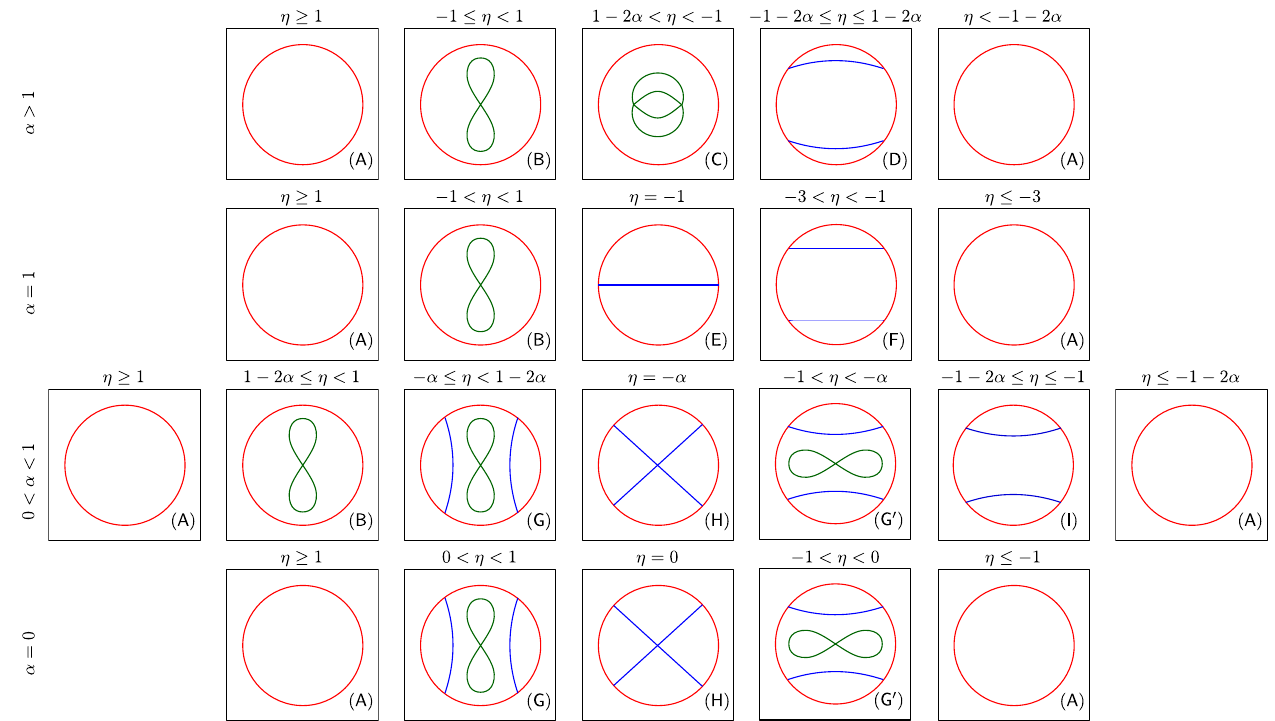
FIG. 3. Possible phase-space topologies for the Hamiltonian (4) as a function of α (vertical direction) and η (horizontal direction), ffiffiffiffiffi ffiffiffiffiffi p p 2 J 2 J using Cartesian coordinates ð cos ϕ ; sin ϕ Þ . Note that η is decreasing from left to right, as we describe a process where η starts at η ≫ 1 and ends at η ≪ 1 . The border of the allowed circle is depicted in red, the coupling arcs are in blue, and the figure-of-eight separatrix is in green. The letters indicate the topology type marked in Fig. 1.